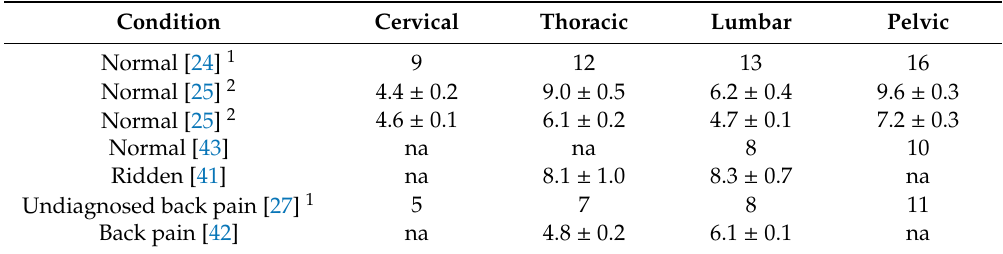
Table 9. Mean MNTs (kg / cm 2 ) within spinal regions measured with 1 cm rubber tipped probe.